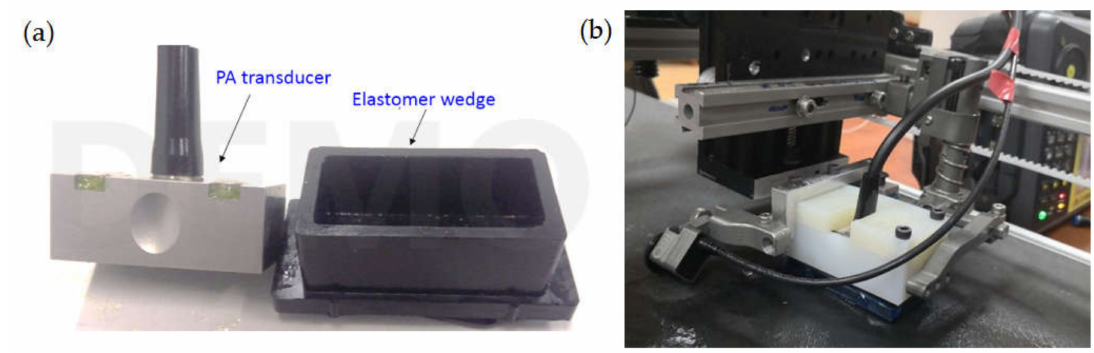
Figure 3. The PA module components ( a ) PA transducer and bespoke low attenuation elastomer wedge ( b ) customized spring-loaded positioning-fixture carrying the PA transducer and wedge in light weight Nylon enclosure and screw- clamped